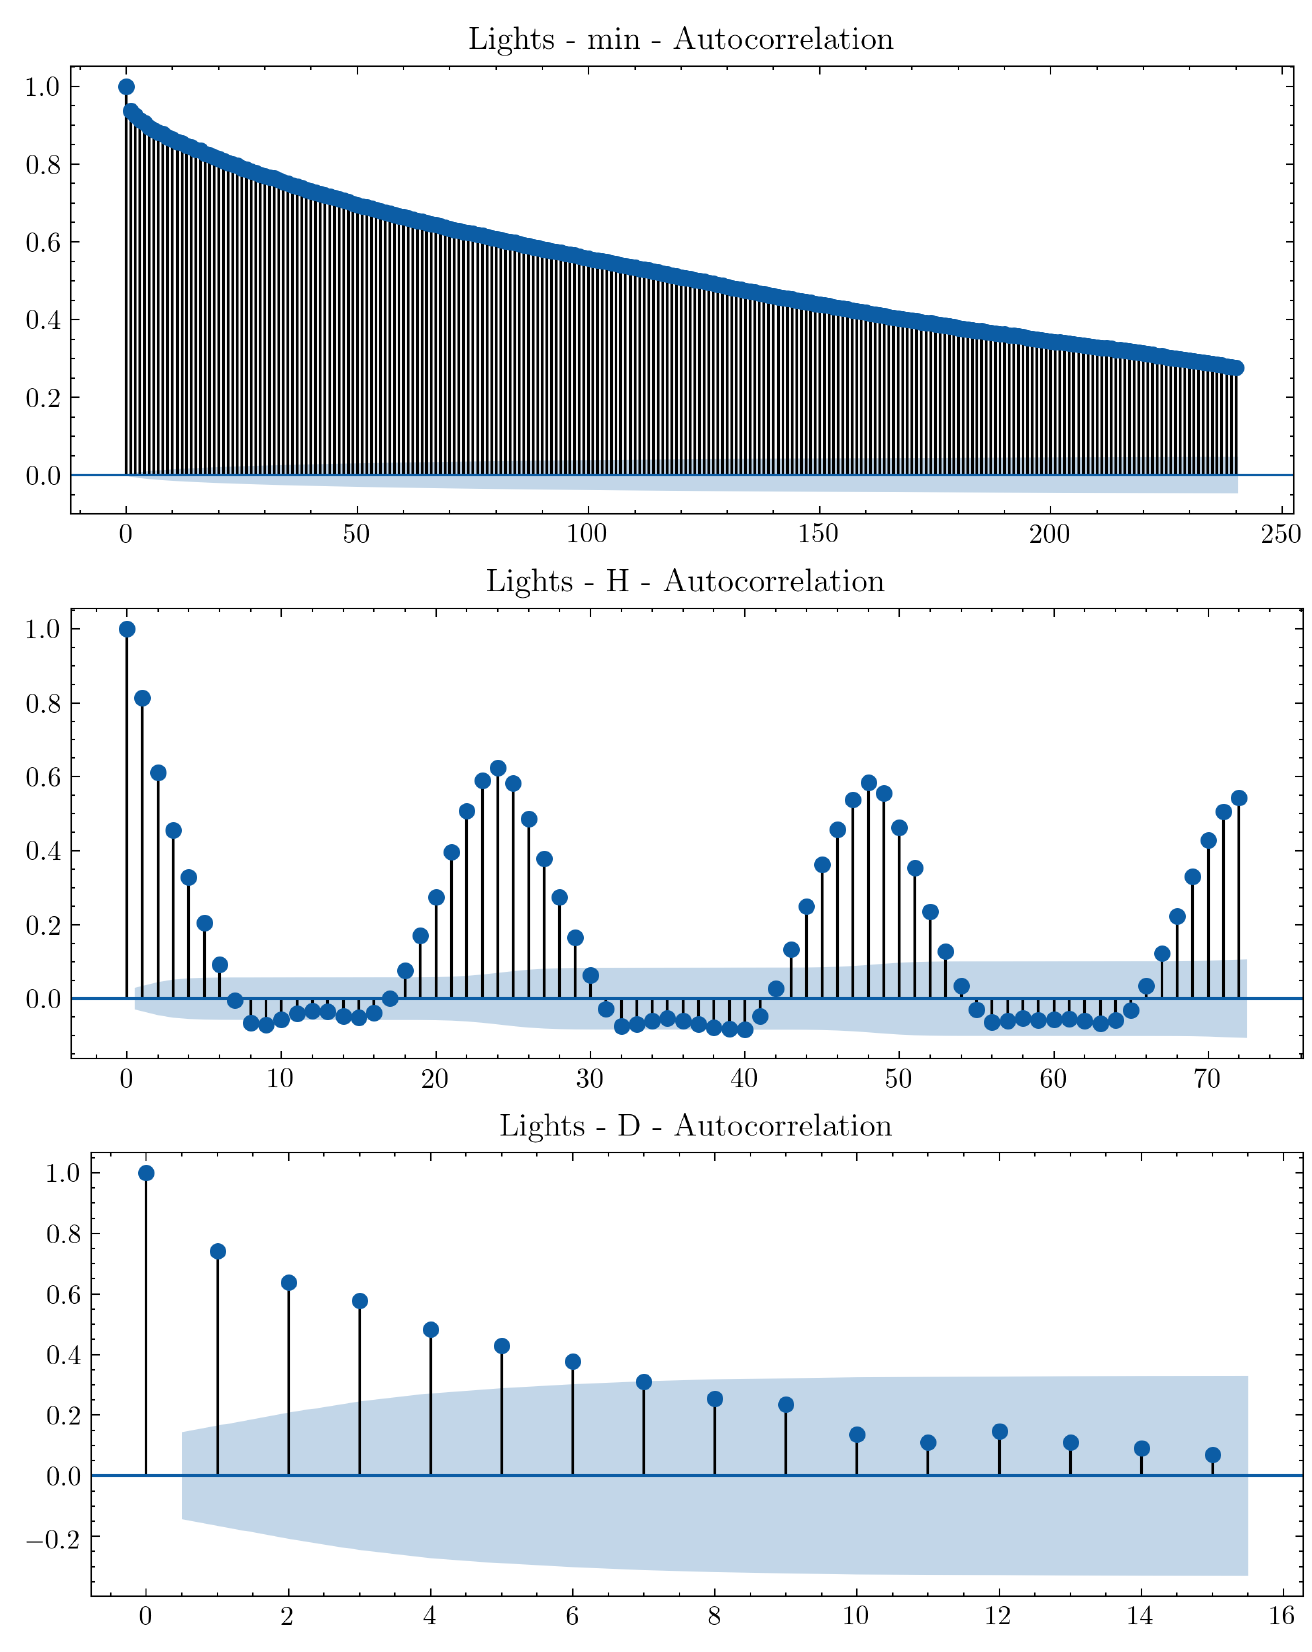
Figure 12. Lights ACF plot for minute, hourly, and daily frequency